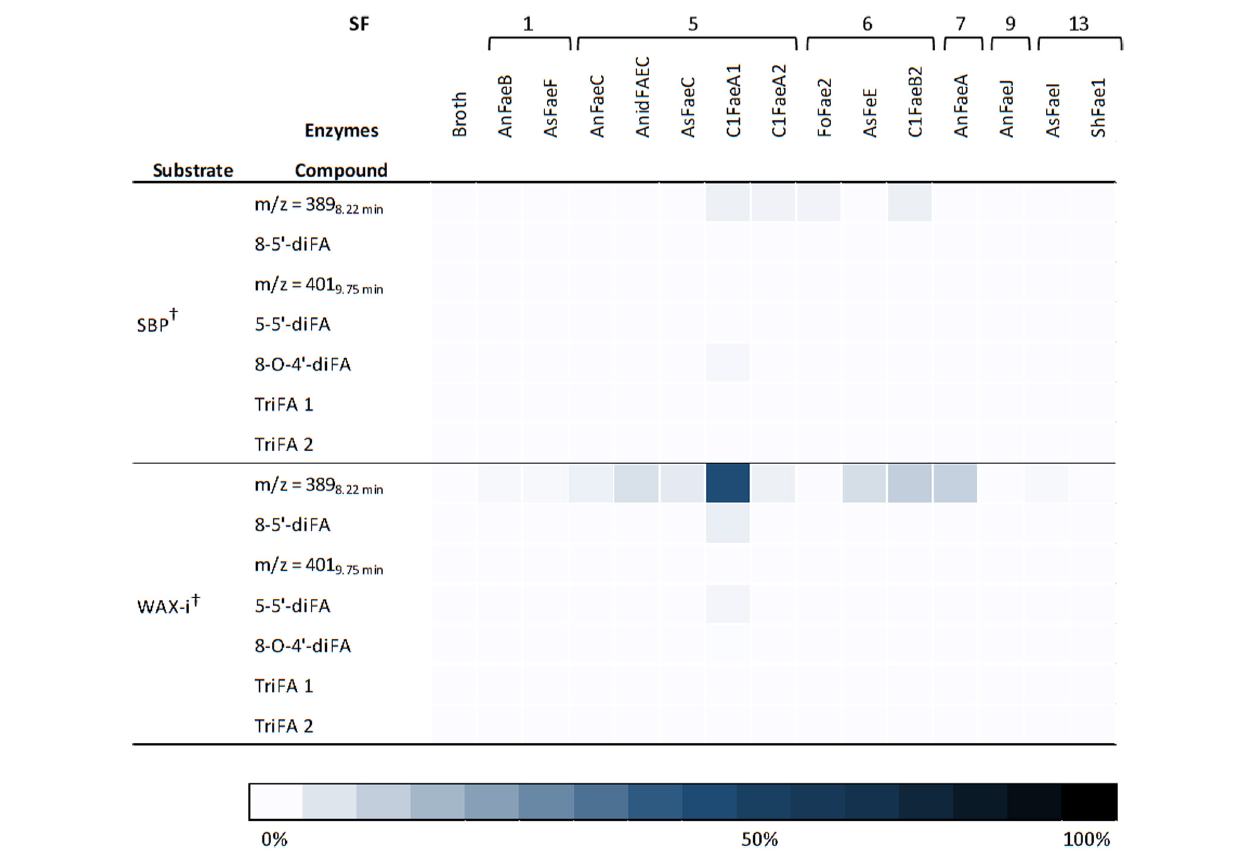
FIGURE 5 | Heatmap presenting the FAE activity toward diFAs and triFAs from incubations with SBP and WAX-i. Substrates were incubated with the 14 FAEs and the fermentation broth for 19 h at 37 ◦ C in duplicates. The results are gives as percentages of bound content as measured by RP-UHPLC-UV ( n = 2). Abbreviations: diFA, diferulic acid; SBP, sugar beet pectin; triFA, triferulic acid; WAX-i, insoluble wheat arabinoxylans. The broth is the culture supernatant of Pichia pastoris which was grown without FAE insertion (negative control). Error bars represent the average standard deviation based on determined absolute numbers. † Estimated by UV. See M&M for